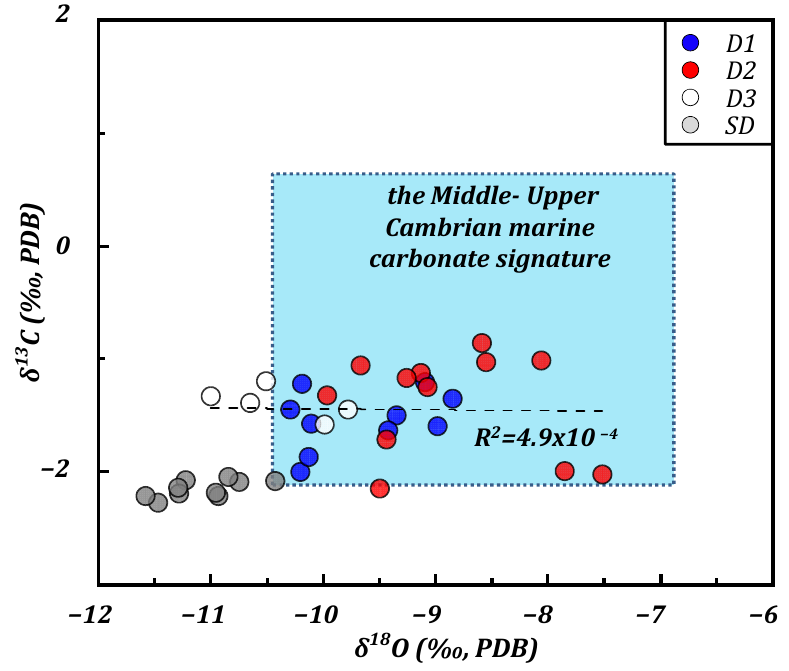
Figure 3. Cross-plot of δ 13 C vs. δ 18 O of different types of dolomites in the Xixiangchi Formation. The δ 13 C and δ 18 O values of the Middle-Upper Cambrian marine carbonate are from [46]. The δ 13 C and δ 18 O values of the SD dolomites were not used for correlation analysis. Note the δ 13 C and δ 18 O compositions of some of D1, D2, and SD samples have been previously reported by Liang et al. [45]. See Table S1 for